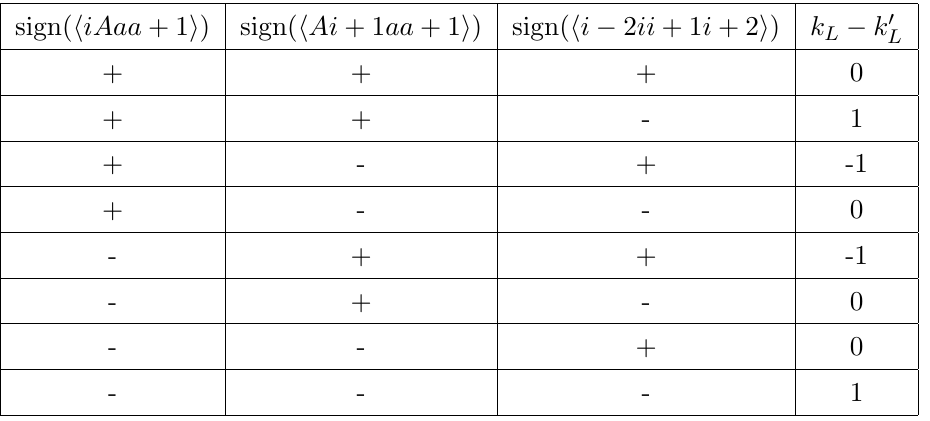
determined according to appendix L